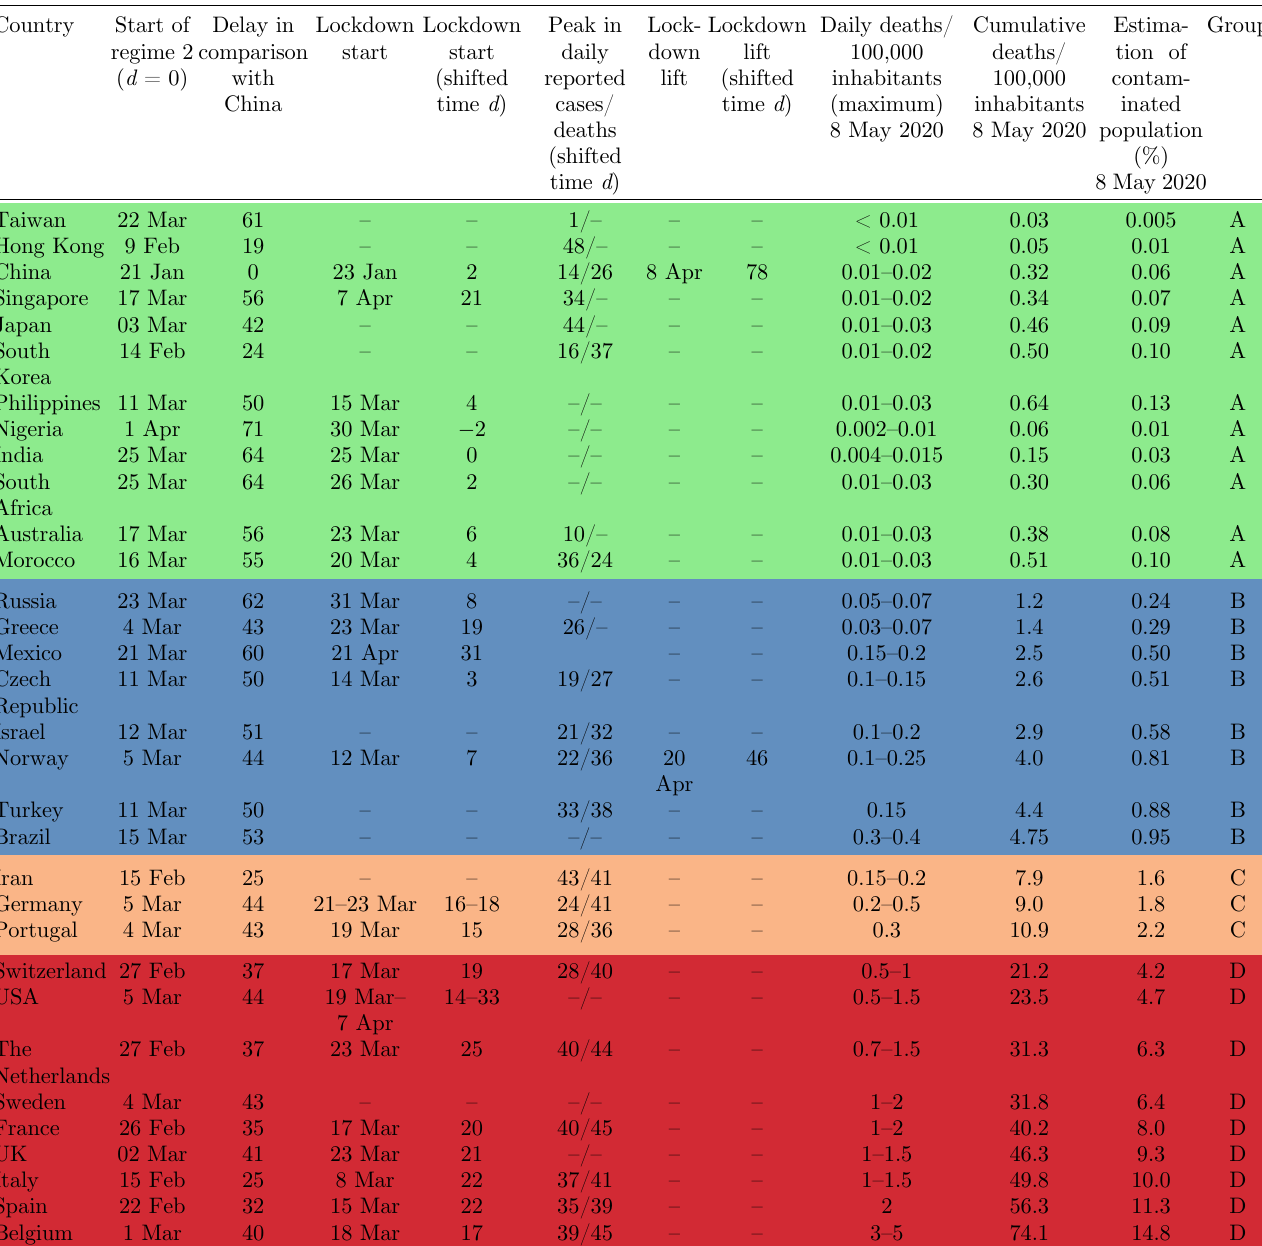
Table 1. Comparison of characteristic times in the propagation of the pandemic, deaths rates (maximum daily deaths and cumulative death tolls, normalized per 100,000 inhabitants, observed till the 8 May 2020) for the selection of 32 countries considered here. Lockdown start and lift dates are from references [26 – 36, 40 – 54]. Assuming a fatality rate of 0.5%, the percentage of population already hit by the virus is estimated for each country. The countries are ranked into four Groups A – D, depending on the degree of propagation of the pandemic in their